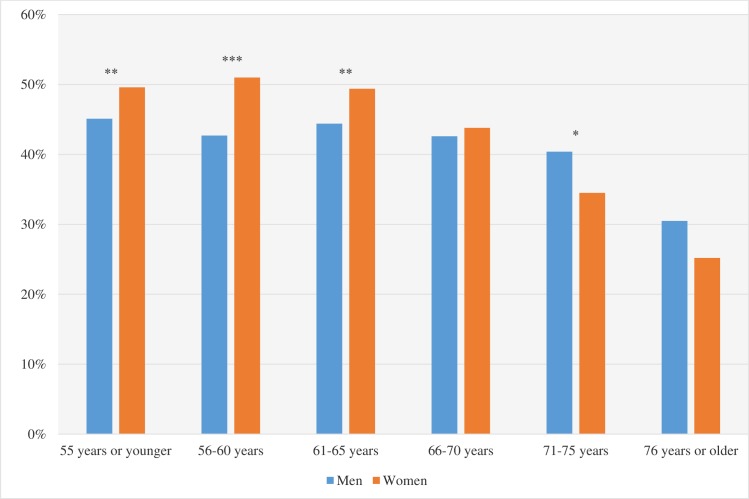
Proportion of patients attending exCR stratified by age groups.The figure shows the proportion of patients attending exCR during the first-year post MI, stratified by gender and age groups. The lowest attendance was observed among the oldest women (≥76 years). *p<0.05; **p<0.01; ***p<0.001.